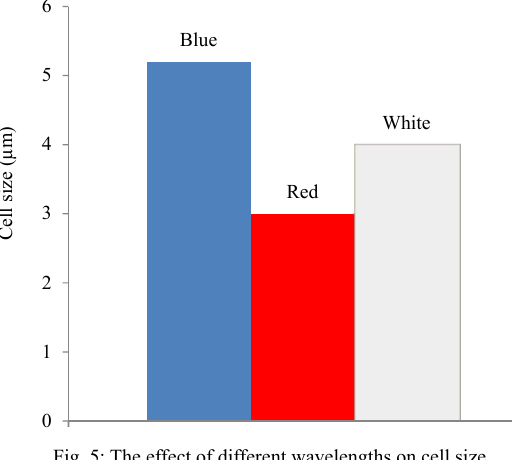
Fig. 5: The effect of different wavelengths on cell size (Wang et al .,